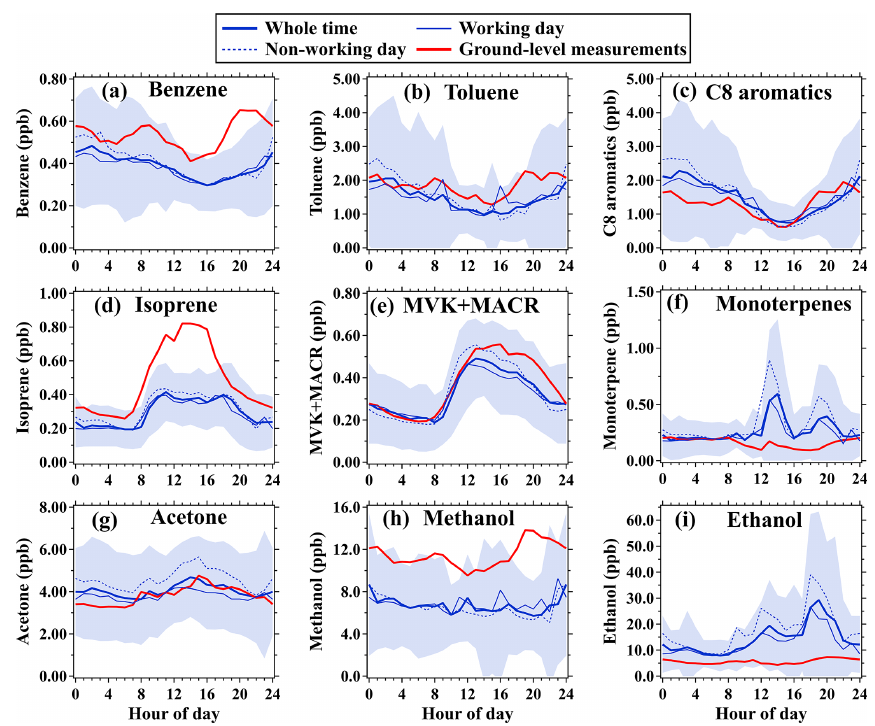
Figure 3. Diurnal variations in mixing ratios of selected VOC species measured by PTR-ToF-MS. Thick blue solid lines and shaded areas represent averages and standard deviations, respectively, during the CTT campaign (18 August–5 November 2020). Red solid lines represent averages during the GIG campaign (11 September–19 November 2018). Thin blue solid and dashed lines represent averages in working days and non-working days (including weekends and public holidays), respectively, during the CTT